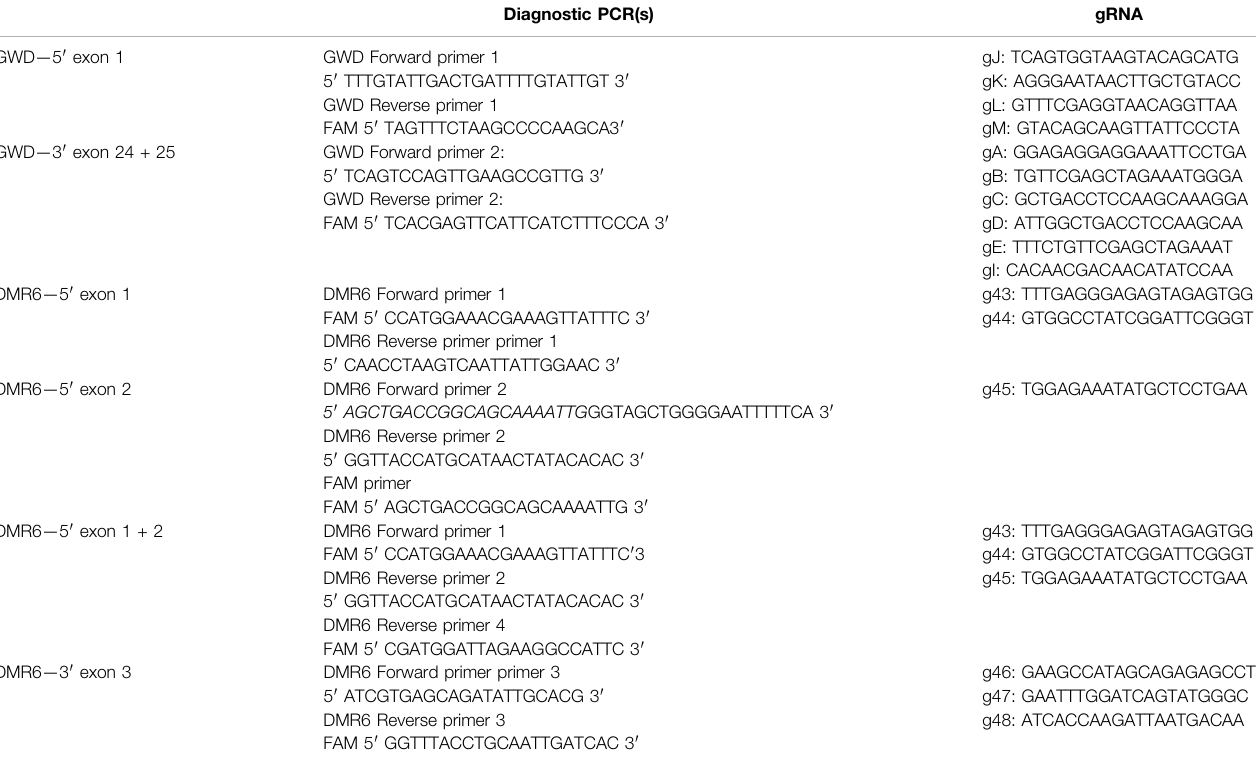
TABLE 1 | gRNAs and diagnostic IDAA primers for each of the four target regions. Scores and fi rst selection of gRNAs were obtained by feeding ca 1 kb regions to the in silico prediction servers CHOPCHOP (http://chopchop.cbu.uib.no/), CRISPRater (https://crispr.cos.uniheidelberg.de/) and SSC (http://crispr.dfci.harvard.edu/SSC/). Diagnostic